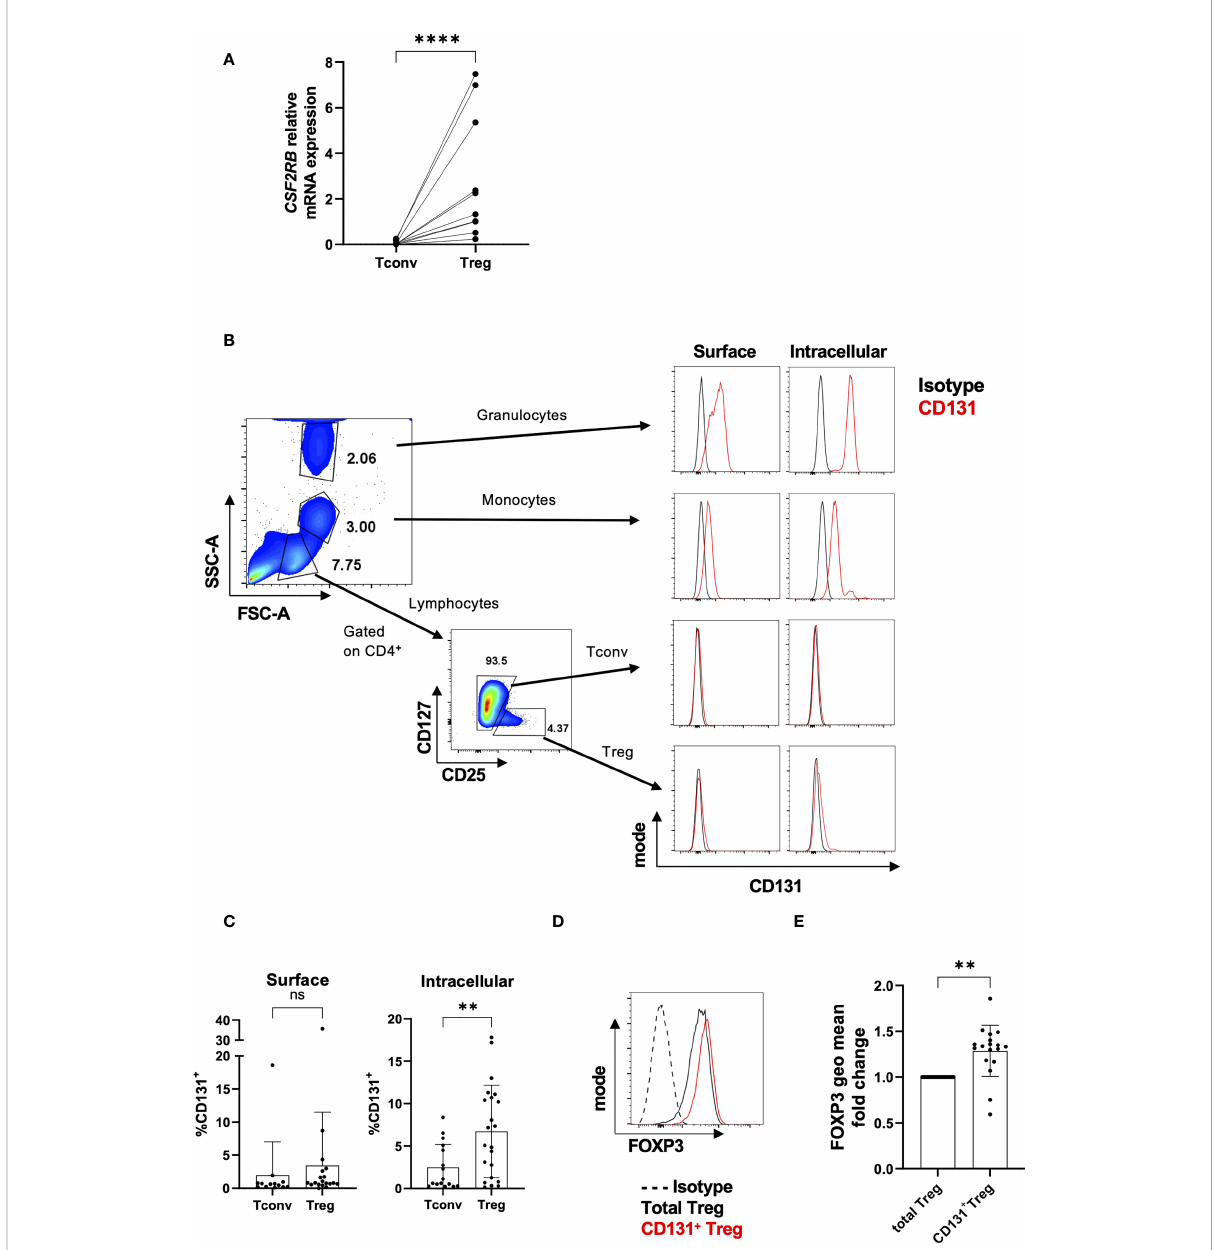
FIGURE 1 Differential CD131 expression in human CD4 + CD25 - Tconvs and Tregs. (A) Relative CSF2RB mRNA levels in fl ow-sorted CD4 + CD25 - CD127 + Tconvs and CD4 + CD25 + CD127 - Tregs from freshly isolated human PBMCs (n= 10). The relative quantities of CSF2RB mRNA were normalized to the expression of B2M mRNA. (B) Granulocytes, monocytes and lymphocytes were gated based on forward and side scatter characteristic of cells from cells obtained from healthy human donors. Tconvs and Tregs were further gated based on CD4, CD25 and CD127 expression. Histograms show CD131 expression (red line) in comparison with matched isotype control (black line) for each cell type. One representative donor out of two. (C) CD131 surface and intracellular protein expression was studied in CD4 + CD25 - CD127 + Tconvs and CD4 + CD25 + CD127 - Tregs in 13-22 independent donors. (D, E) FOXP3 expression was analyzed within the total Treg population or within CD131 + Tregs. (D) Representative FACS plot for one donor. (E) FOXP3 fl uorescence intensity in CD131 + Tregs normalized to the total Treg population (n=18 independent donors). Graphs display mean ± SD. Normal distribution was assessed by Shapiro-Wilk normality test with a signi fi cance level of 0.05. Signi fi cance was calculated by (A, C) Mann-Whitney test or (E) Wilcoxon matched-pairs test. ns for P > 0.05, ** for P ≤ 0.01, **** for P ≤